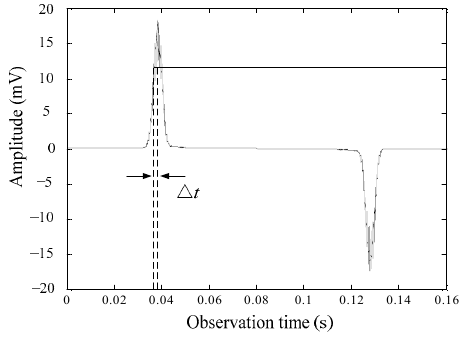
Figure 2. Noise affects the induction output signal.